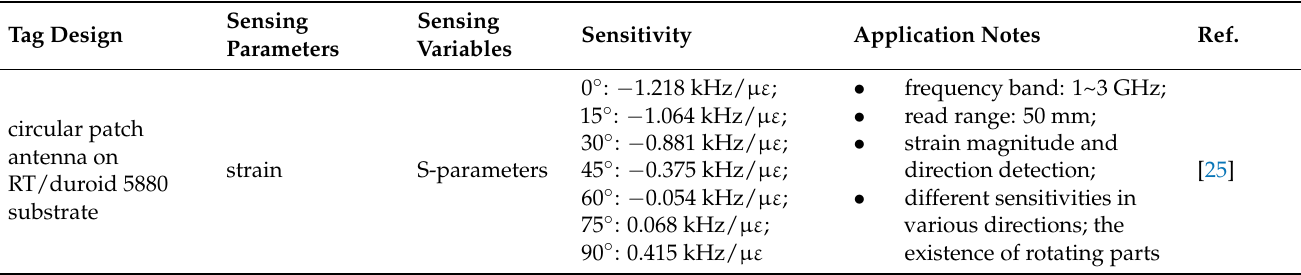
Table 7. Chipless RFID sensor tags for